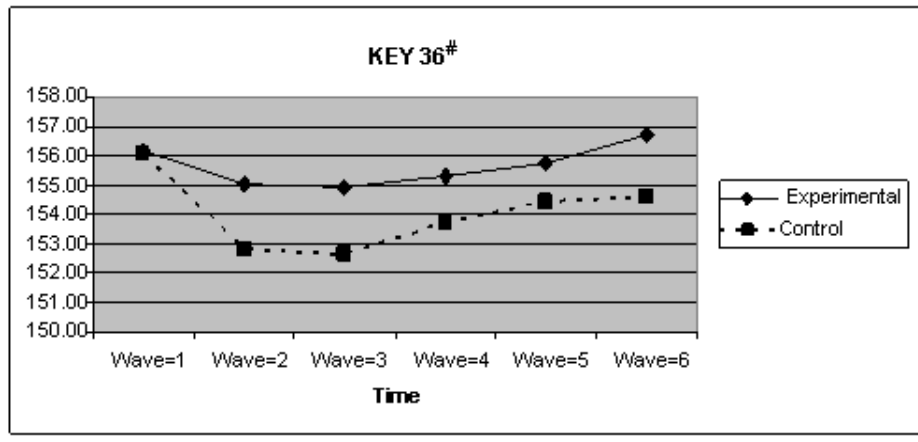
FIGURE 2. Growth trajectories of the experimental participants and control participants using KEY 36 # as an outcome indicator. # 36 key items of the Chinese Positive Youth Development